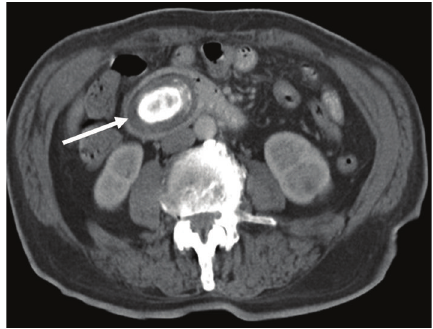
Figure 3: On post-contrast axial CT image a giant gallstone is seen occupying the 3rd and 4th portions of the